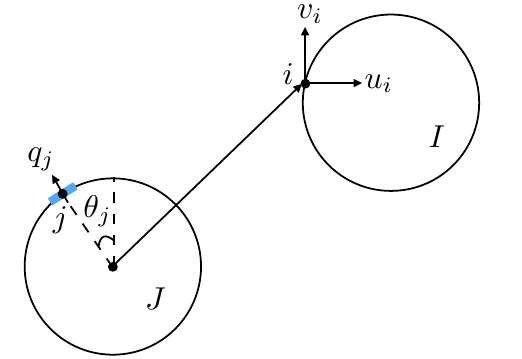
Figure 4. Influence of load at location j of turbine J onto location i of turbine I